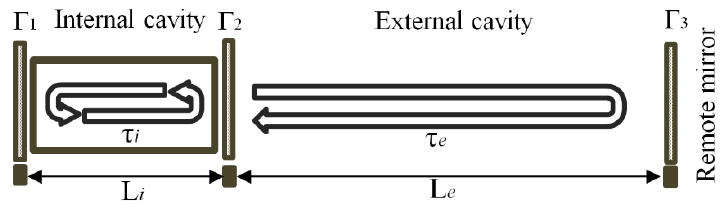
Figure 1. External cavity model attached to FP laser’s internal cavity.